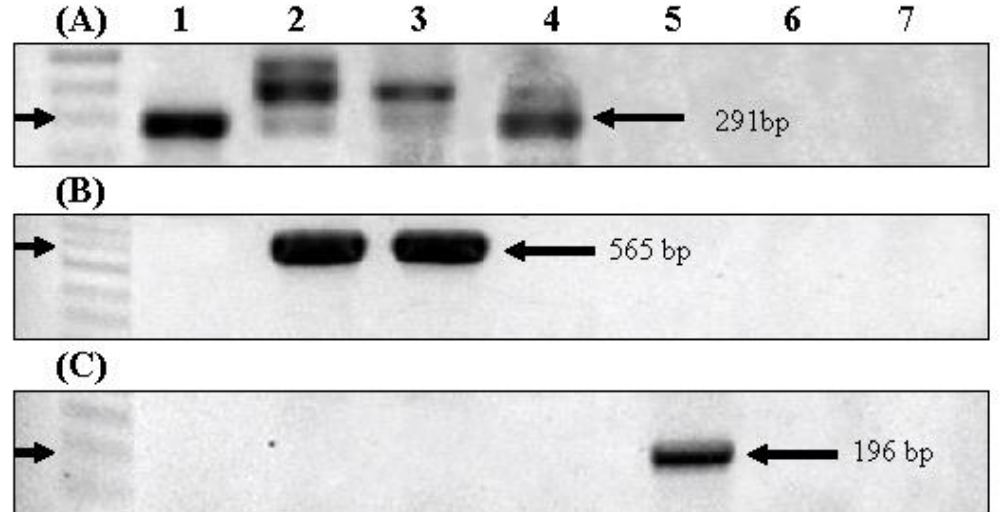
Figure 3. Agarose gel electrophoresis of PCR amplicons for ( A ) microcystin ( mcyA gene), ( B ) geosmin ( gys gene), and ( C ) 2-MIB ( mibC gene) synthesis genes. 1: Microcystis aeruginosa , 2: Dolichospermum circinale ( Anabaena circinalis ) ST, 3: D. circinale ( A. circinalis ) CT, 4: Aphanizomenon flos-aquae , 5: Oscillatoria limosa , 6: Planktothricoides raciborskii , 7: Pseudanabaena mucicola .